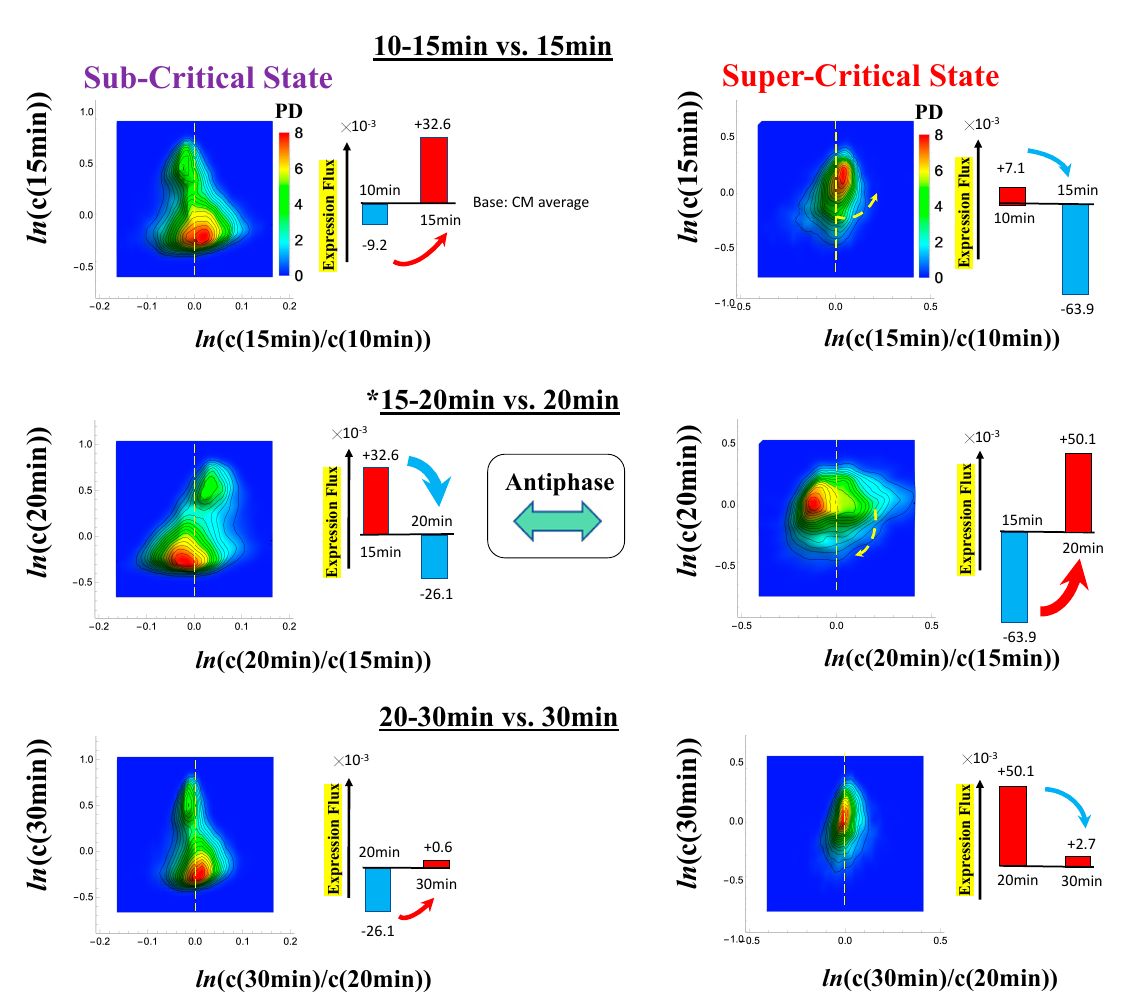
Figure 13. Dynamics of coherent behaviors around a phase transition in HRG-stimulated MCF-7 cells. The PDF (Section 4.2.3) reveals that the dynamics of coherent behaviors emerge in the stochastic gene expression in local critical states (sub-critical: left panel and super-critical states: right). This describes the anti-phase dynamics between the critical states and how sub-critical and super-critical attractors (Figure 11) dynamically self-organize stochastic gene expression as coherent oscillatory dynamics (see details in [6,7]). The vertical ( x -axis) coherent oscillatory (up- and down-) regulations are explained by positive (obtaining flux) and negative (sending flux to other states) expression flux dynamics of critical states based on the genome engine (refer to Section 3.1). The biggest change in expression flux occurs between 15–20 min, which coincides with the timing of a global avalanche (Figure 4). The x - and y -axes represent the natural log of the fold-change and whole-genome expression vectors from the CM of critical states (Section 4.2.3), where whole-genome expression is ordered by the degree of nrmsf (see Figure 1).